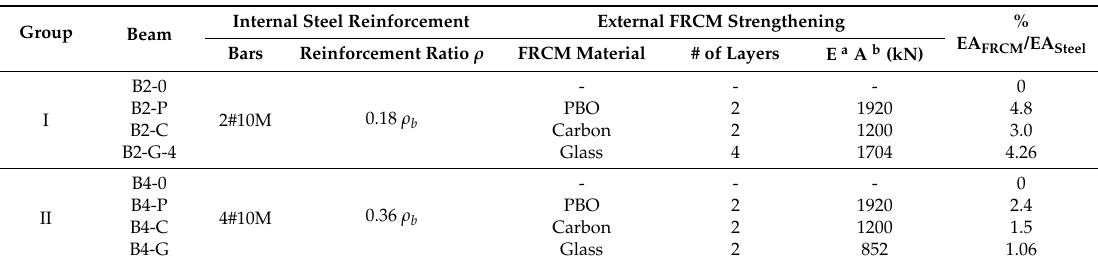
Table 1. Test matrix. B, beam; P, PBO; G, glass.